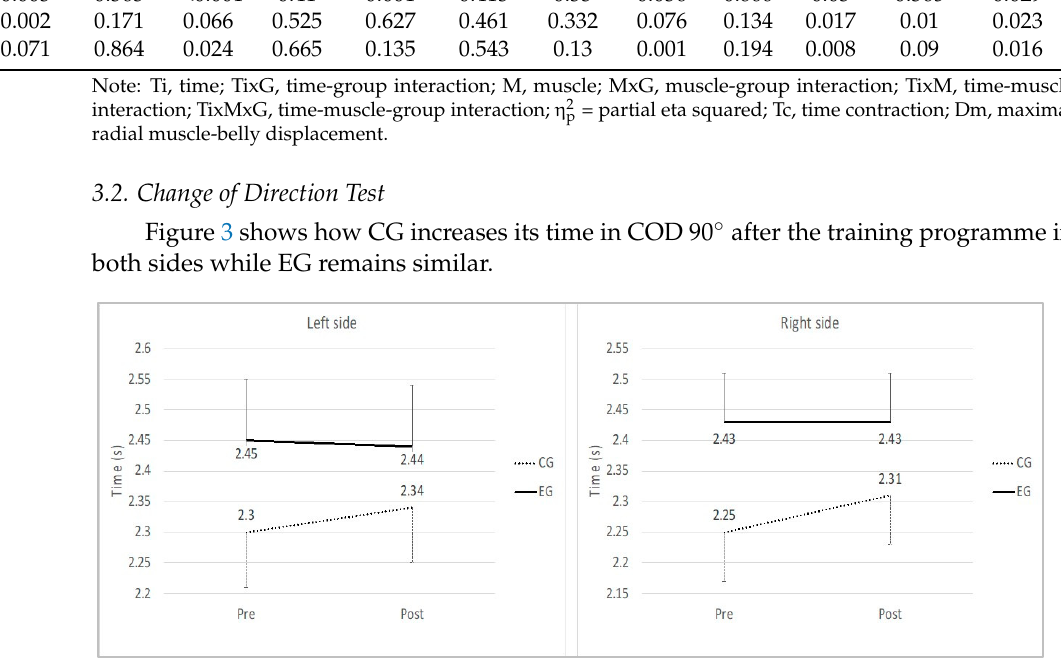
Figure 3. Changes in COD 90° values to the left side and the right side. Note: Pre, first assessment moment; Post, second assessment moment; CG, control group; EG, experimental group. moment; Post, second assessment moment; CG, control group; EG, experimental